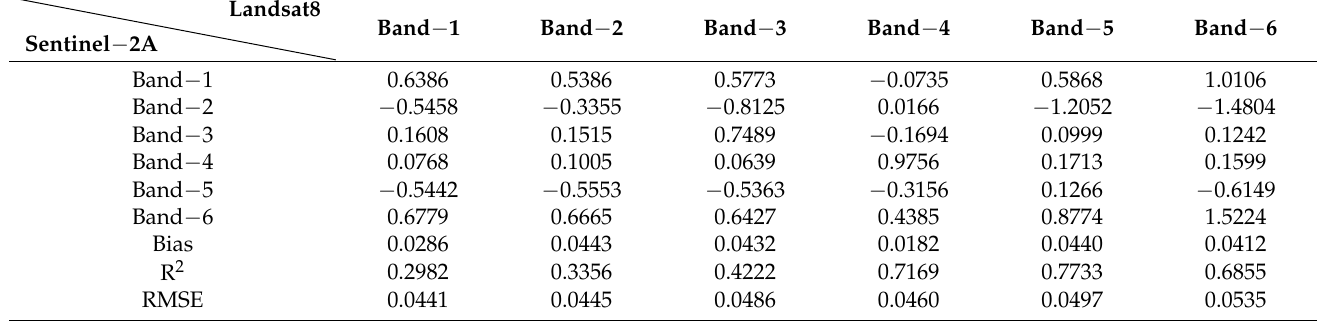
Table 3. Transfer coefficients and error of point − multi between Sentinel − 2A and Landsat − 8 OLI.